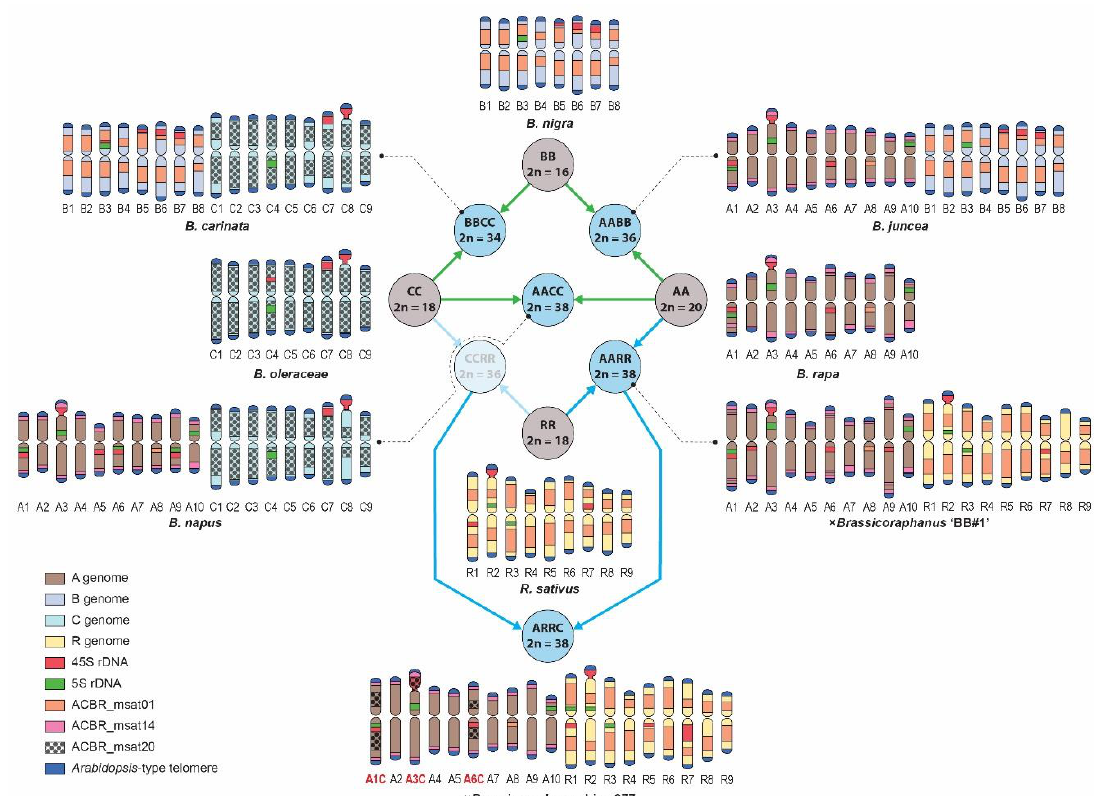
Figure 6. Karyotype ideograms and genome relationships between the four diploids and their allotetraploid hybrids. Green arrows show the genome relationships among species within the U’s Triangle, and blue arrows for those involving the R genome. The A, C, B, and R genomes are distinguished by chromosome color. The chromosome numbers of × Brassicoraphanus 977 with ACBR_msat20 signals are highlighted red.